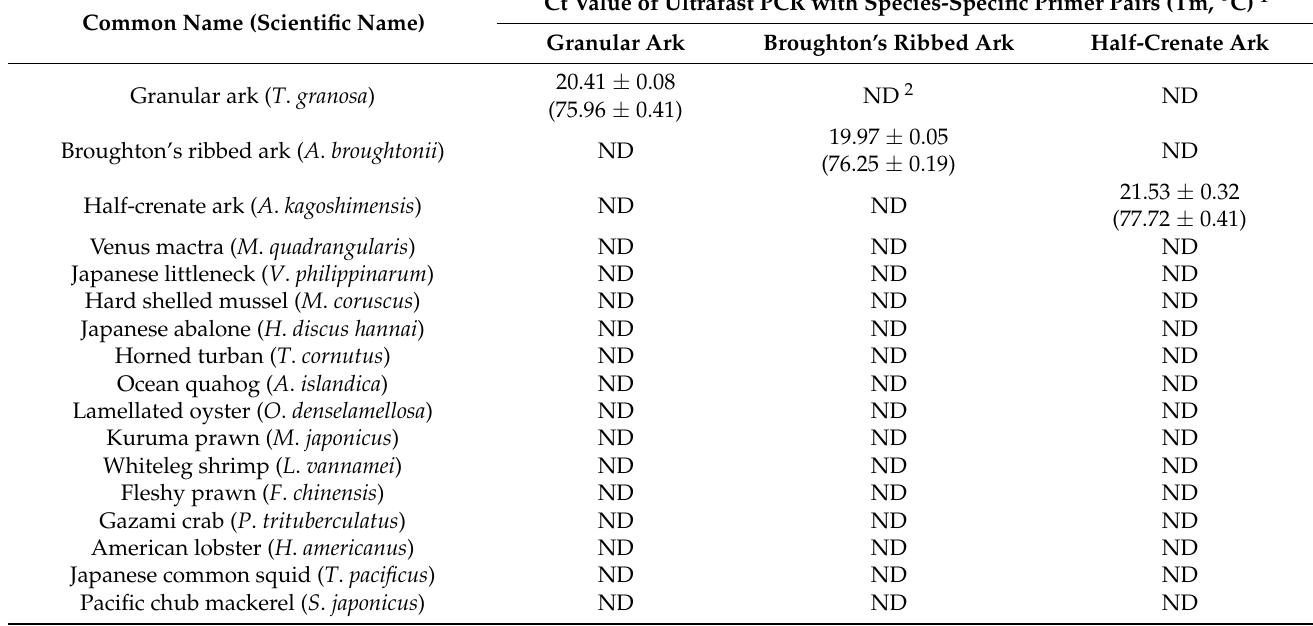
Table 3. Specificity results of ark shells specific ultrafast PCR assay.